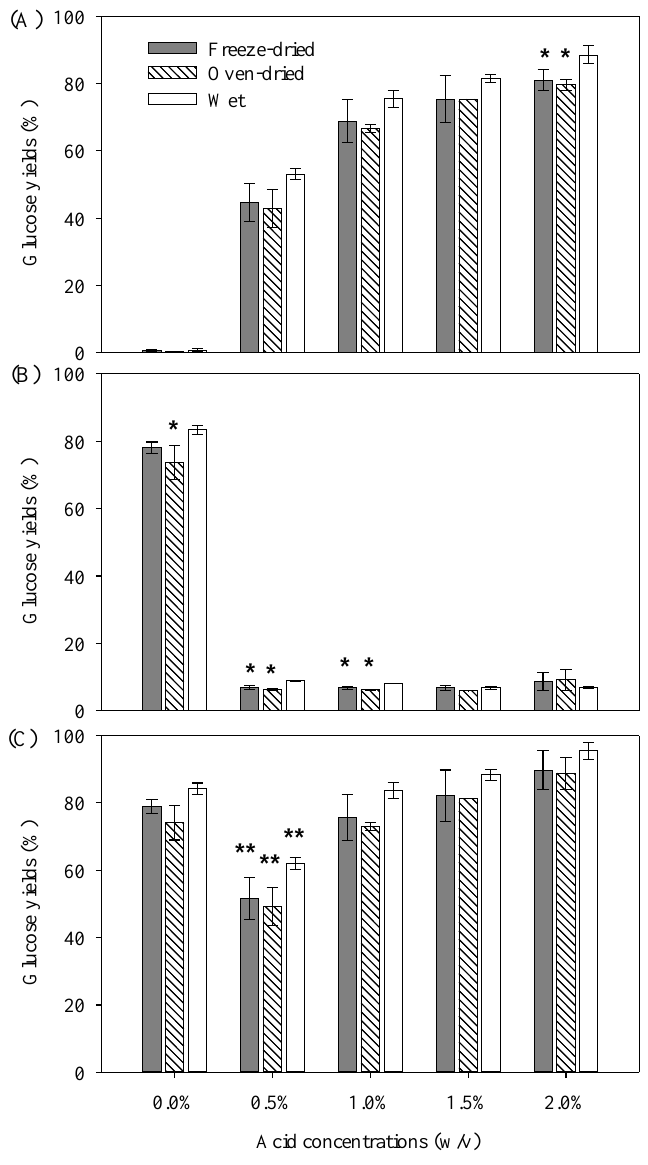
Figure 2. Glucose yields of freeze-dried, oven-dried, and wet microalgal biomasses obtained by acidic pretreatment followed by enzymatic hydrolysis: ( A ) yields of glucose released to hydrolysates after pretreatment by different concentrations of acid; the * indicate the significant differences ( p < 0.05) of freeze-dried and oven-dried samples compared to wet sample; ( B ) yields of glucose released after residue hydrolysis by amy ( α -amylase and amyloglucosidase) and cellulase; the * indicate the significant differences ( p < 0.05) of freeze-dried and oven-dried samples compared to wet sample; ( C ) total glucose yields with a combination of pretreated and enzymatic hydrolysates; the ** indicate the significant differences ( p < 0.01) of samples pretreated by 0.5% sulfuric acid compared to that pretreated by water and other acid